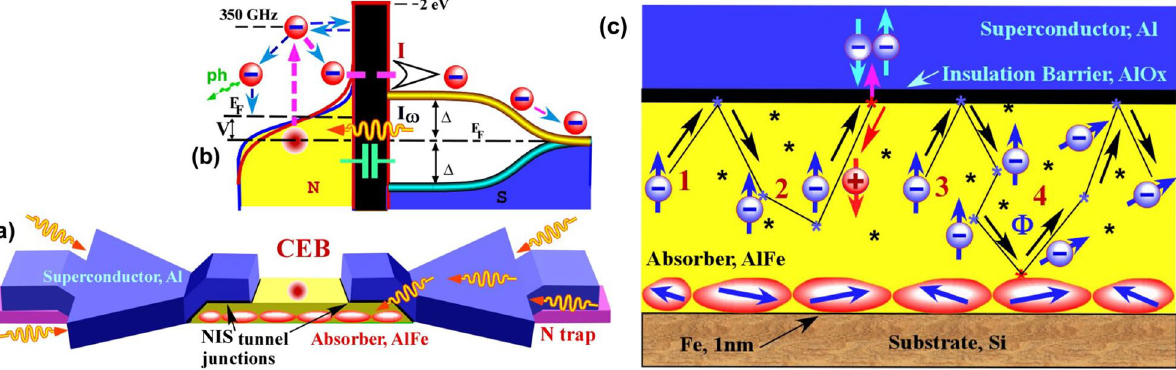
Figure 1. ( a ) 3D scheme of CEB. The absorber is shown in yellow (Al) with red grains (Fe). The superconductivity of Al is suppressed by Fe grains. Blue are superconducting electrodes, magenta are normal metal traps, thin black interlayers are the tunnel barriers of NIS junctions. The incoming photons (orange waving arrows) generate rf-current in AlFe absorber. ( b ) Energy diagram of CEB. One photon is absorbed by one electron (top red ball), which redistributes its energy between other electrons in absorber N, changing the temperature of Fermi distribution. When voltage V is applied across the NIS junction, the hottest electrons tunnel into S (current I). After that, the electrons move away from the tunnel barrier and lose their energy in N trap. ( c ) Schematic representation of Andreev current suppression in AlFe due to the presence of Fe grains. Symbols “ ” indicate defects and impurities in Al. Paths 1 (reflection) and 2 (Andreev reflection) are present in a ∗ typical normal metal. Paths 3 and 4 show that an electron spin is not constant, if the scattering on the magnetic grains happens, decreasing the probability of Andreev